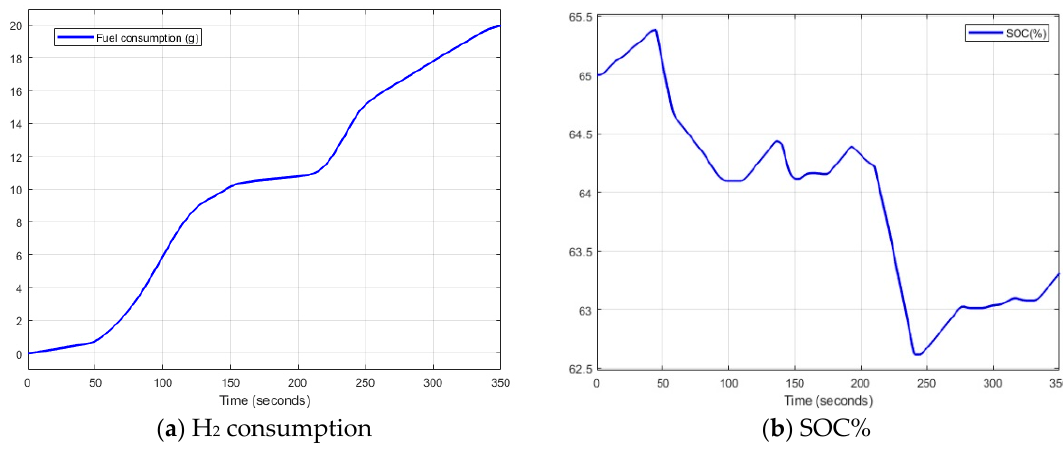
Figure 24. Performance of the high frequency decoupling and state machine control strategy.